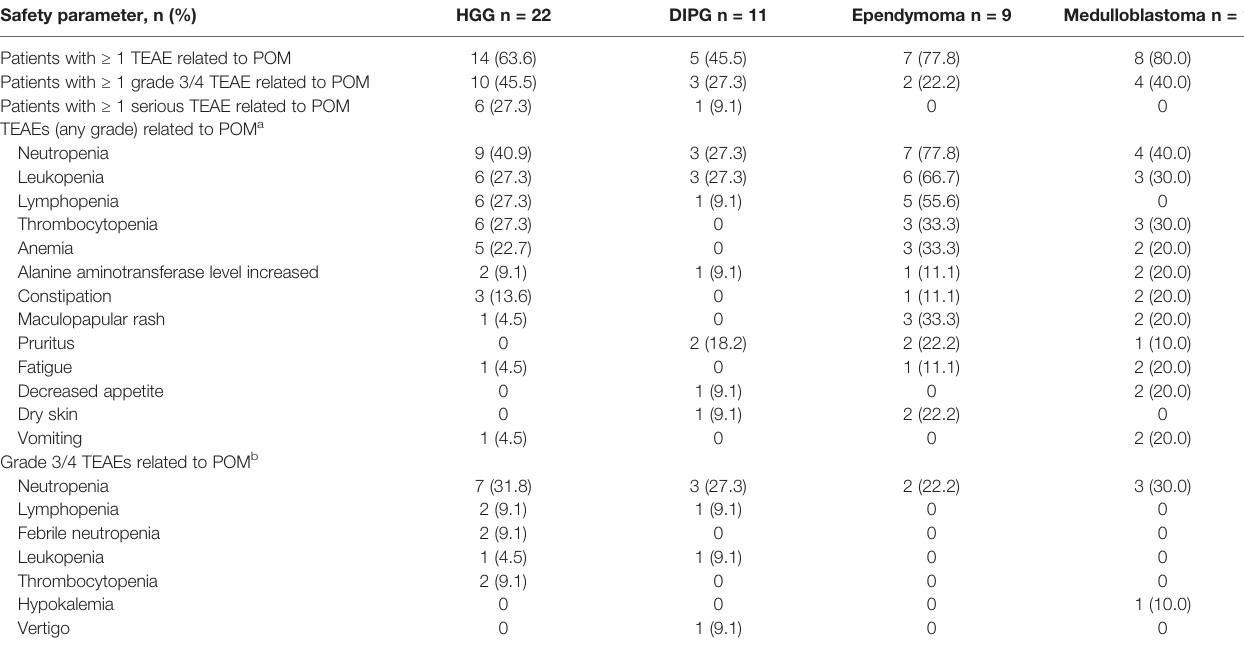
TABLE 4 | Safety (safety population). Safety parameter, n